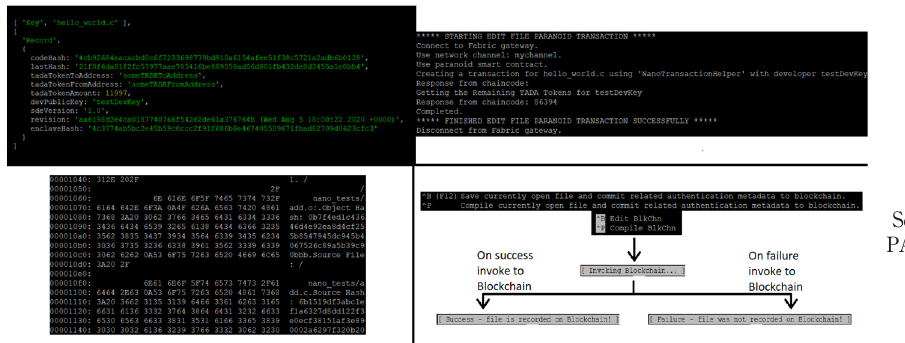
Figure 9. Screenshots from